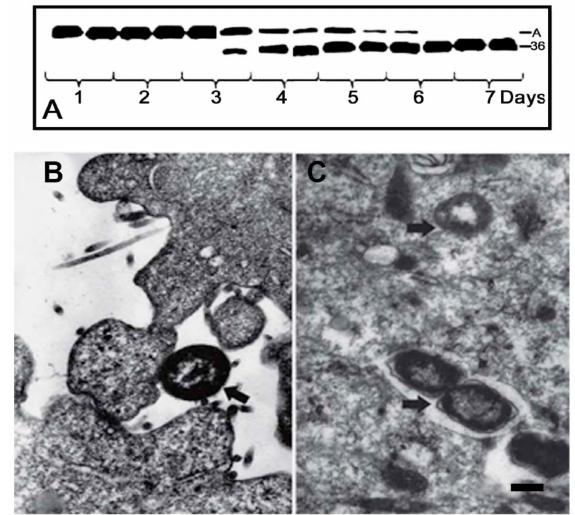
Figure 2. Apathogenic Shigella flexneri 5a2c mutant treated with furazolidone can invade eukaryotic cells. ( A ) Detection of the actinase activity in the lysates of Shigella flexneri 5a2c acquired upon the furazolidone treatment. Numbers indicate the time points of bacteria growth when their extracts were tested for the actinase activity. A, actin; 36, the 36 kDa actin fragment. ( B ) Incubation of human larynx carcinoma Hep-2 cells with the furazolidone-treated non-pathogenic Shigella flexneri 2a 4115. ( C ) Invasion of the pathogenic furazolidon-treated Shigella flexneri 5a2c into human larynx carcinoma Hep-2 cells [39]. Arrows indicate extracellular bacterium ( B ) and intracellular bacteria lying in vacuoles ( C ). Scale bar, 0.5 µ m. Reproduced from [45] with permission from Springer Nature License 4823180887079,